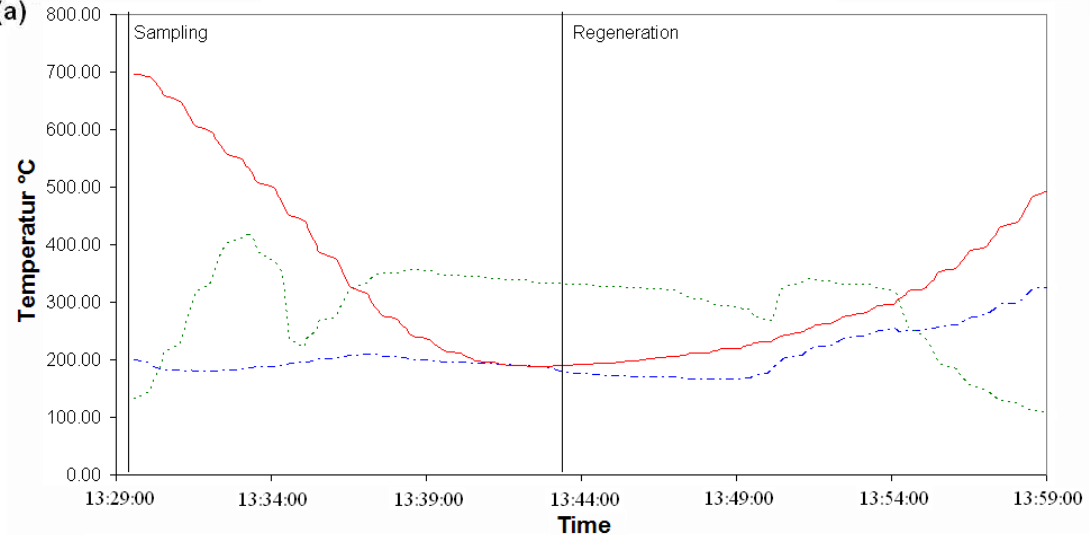
Figure 5. Temperatures in catalytic reactor under different flow rates: ( a ) Syngas flow rate 20 Nm 3 /h; ( b ) Syngas flow rate 15 Nm 3 /h; and ( c ) Syngas flow rate 10 Nm 3